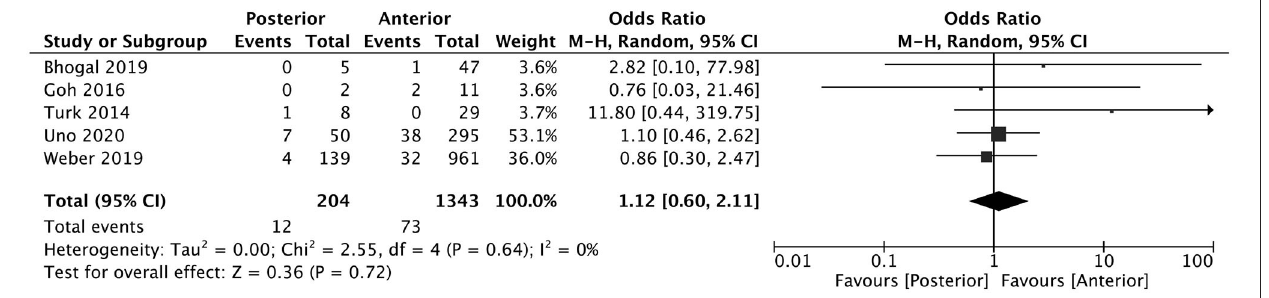
FIGURE 3 | Effect of anterior vs. posterior circulation vessel occlusion on subarachnoid hemorrhage following mechanical thrombectomy.